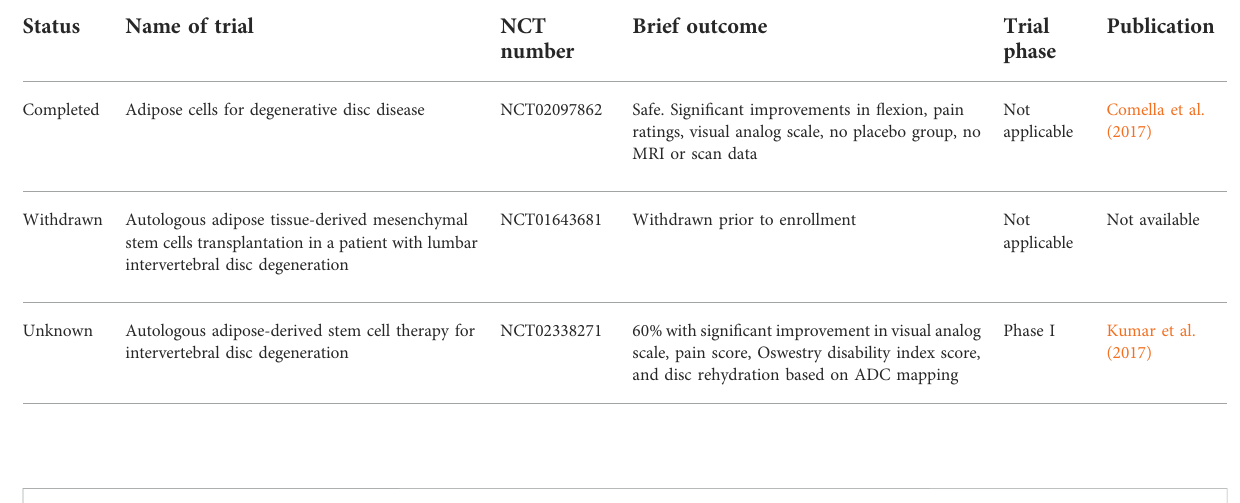
TABLE 1 A recently conducted search shows applications for adipose stem cells in treating IVDD.